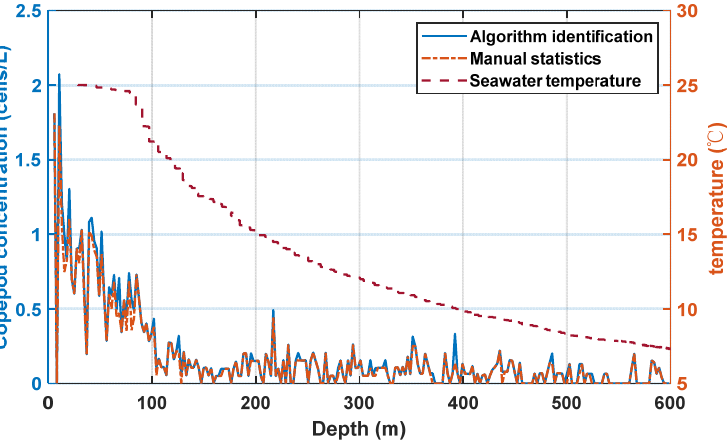
Figure 17. Copepoda numbers found at different depths by the DHUG’s results obtained from the automatic (red) and manual (blue) processing of the hologram sequences from the South China